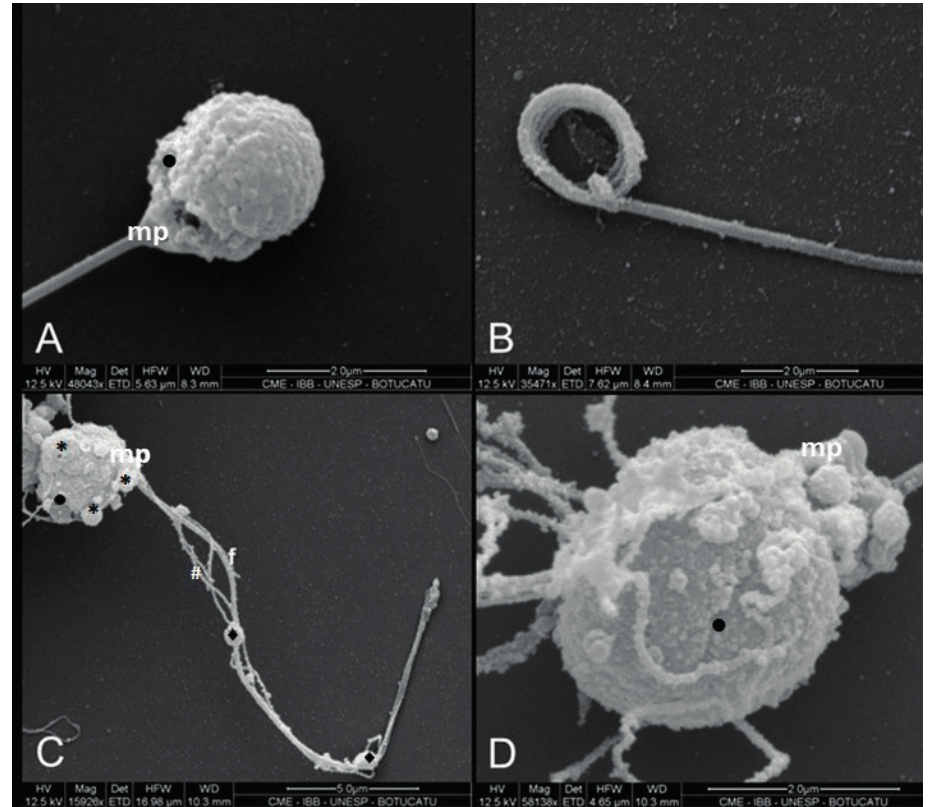
FIGURE 5 | Morphological analysis of thawed sperm from Pseudoplatystoma corruscans . A. Sperm with changes in the head, rupture of the membrane and damage to the intermediate part. B. Curled flagellum. C. Spermatozoon with damage to the head, intermediate piece and flagellum. D. Sperm head with changes in the head, damage to the membrane and damage to the intermediate part. Legends: ● = membrane rupture, * = possible cytoplasmic material, # = flagellar fibers, ♦ = cytoplasmic gout. Scale bars; A, B, and D = 2 µm; C = 5 µm.